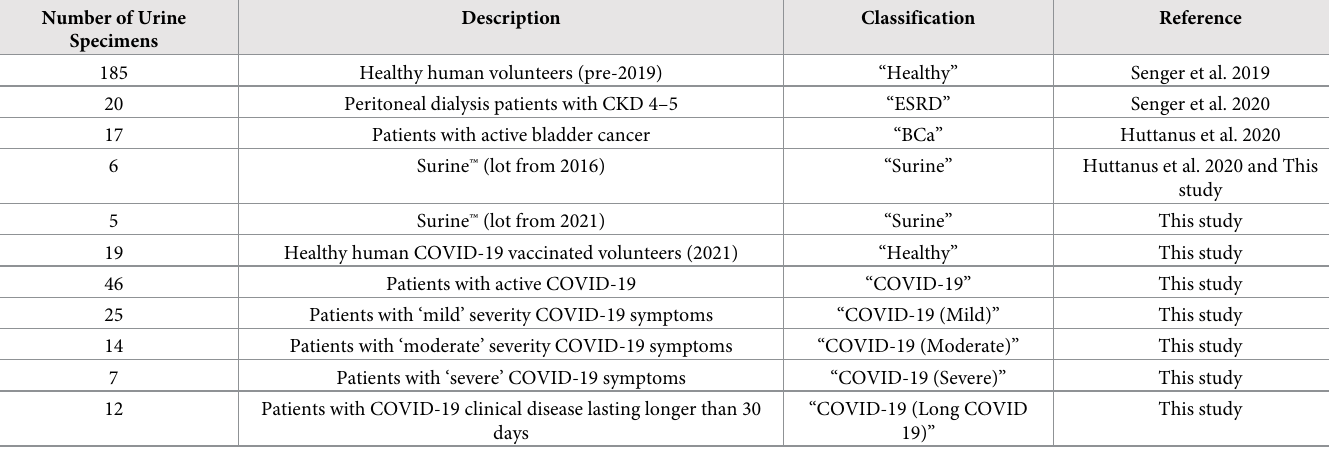
Table 1. Patient dataset analyzed in this